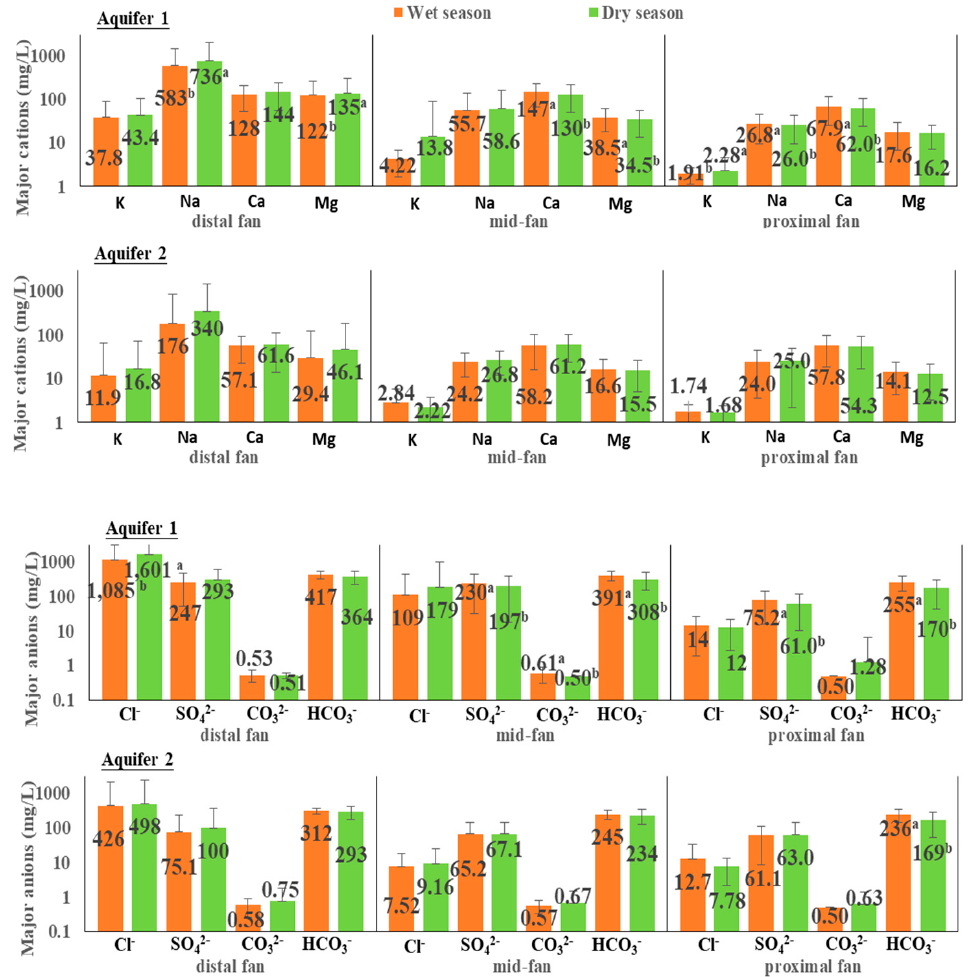
Figure 7. The mean concentrations of major cations and anions in addition to the statistical results of the proximal fan, mid-fan, and distal fan areas in both aquifers between the wet and dry seasons. (a superscript character after the mean value means that the water quality parameter has significant differences)